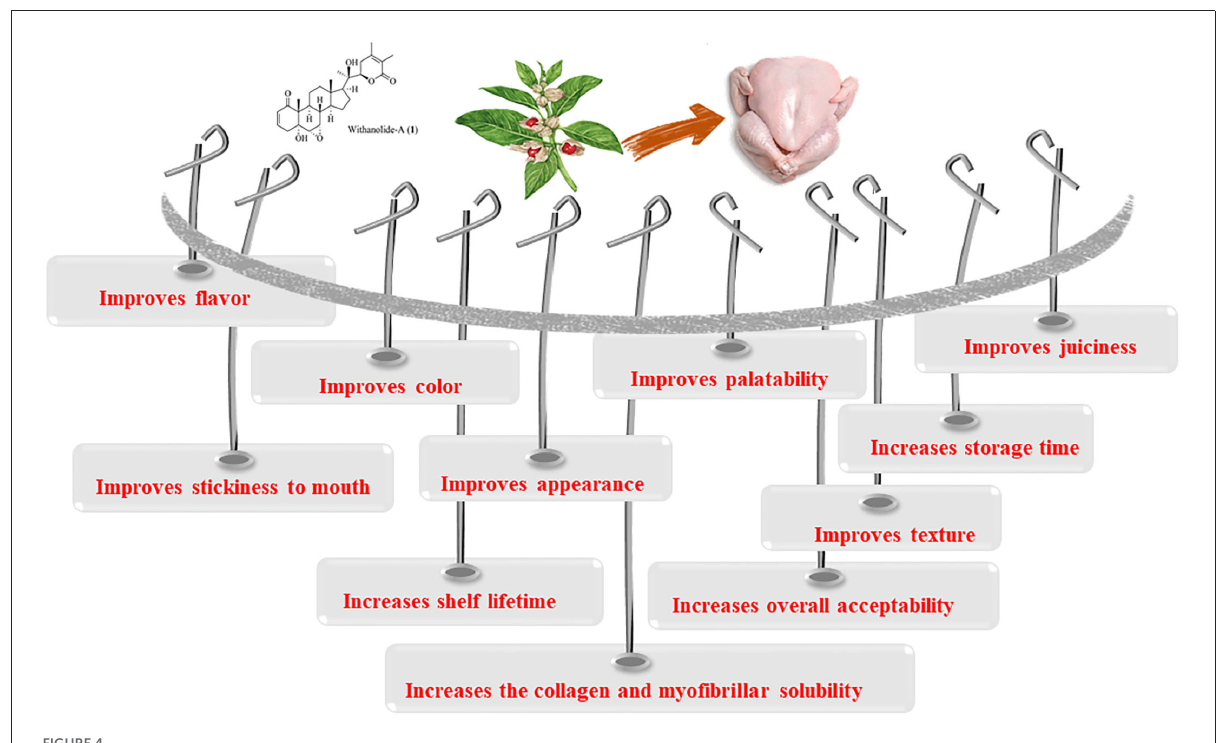
FIGURE4 Impacts of Withania somnifera supplementation on broiler meat